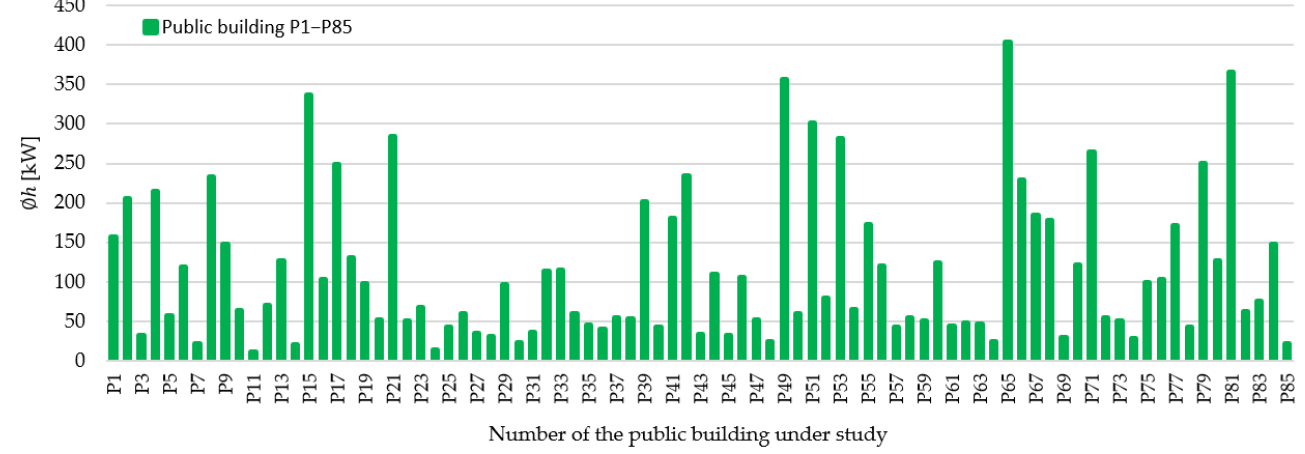
Figure 2. Compilation of values of approximate power demand ∅ ℎ for heating the studied group of public buildings.